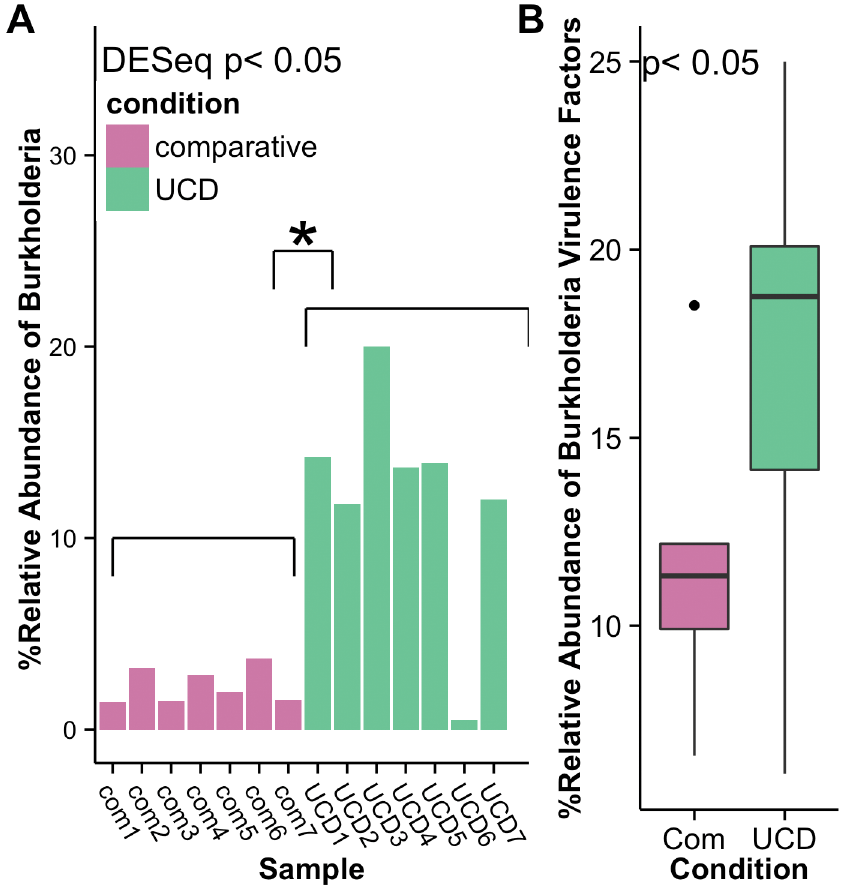
Fig 5. Burkholderia and Burkholderia virulence factors across samples. (A) Relative abundance of sequences similar to the genera of Burkholderia and (B) Relative abundance of sequences similar to Burkholderia virulence factors in comparative (com) and unknown cause of death (UCD) harbor seal samples.